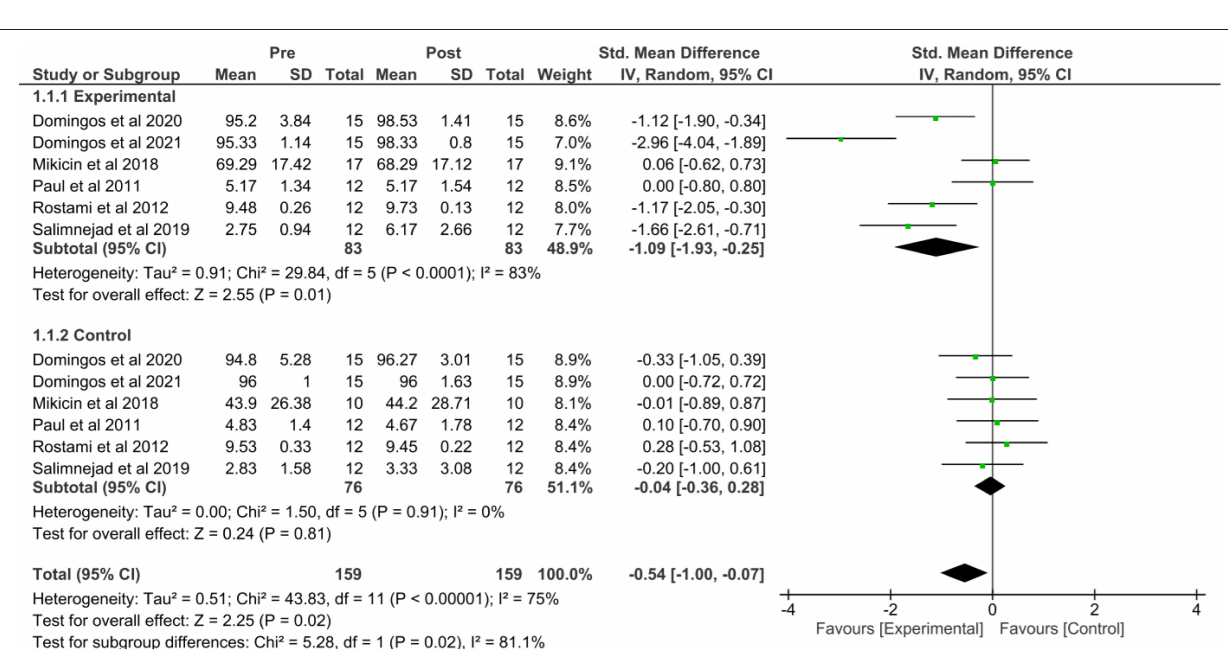
FIGURE 4 | Forest plot comparing the NFB and control groups with the pre and post-performance. Created using Software Review Manager